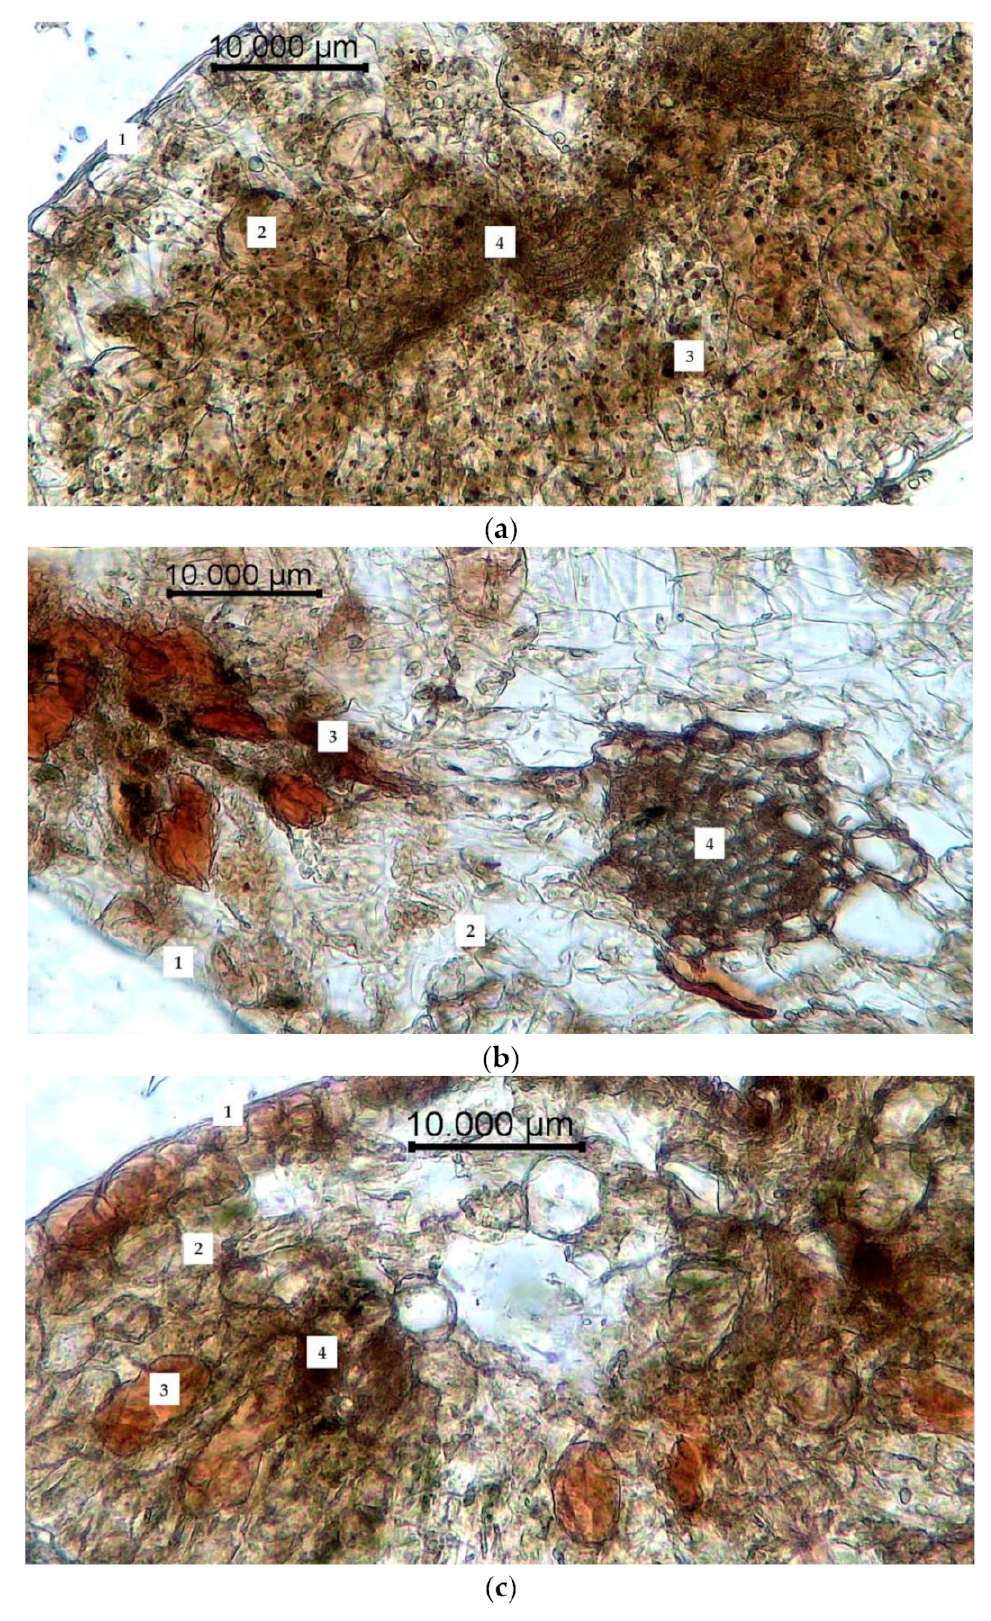
Figure 5. Changes in the anatomical structure of the leaf of R. semenowii under stress conditions: ( a ) control, ( b ) water deficit (cessation of watering, 72 h), ( c ) cold stress (cold treatment +3 ◦ C, 72 h). 1—epidermis; 2—mesophyll, 3—inclusions; 4—conductive bundle; scale bar = 10 µ